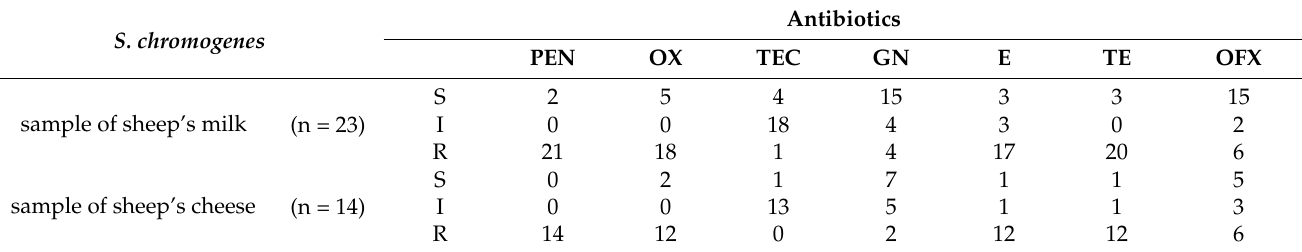
Table 2. Number of susceptible (S), intermediate sensitive (I), and resistant (R) isolates of S. Chromogenes .